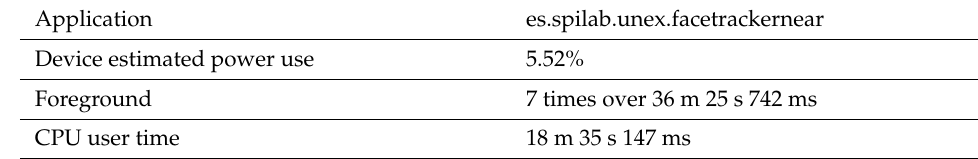
Table 2. Patient’s device battery